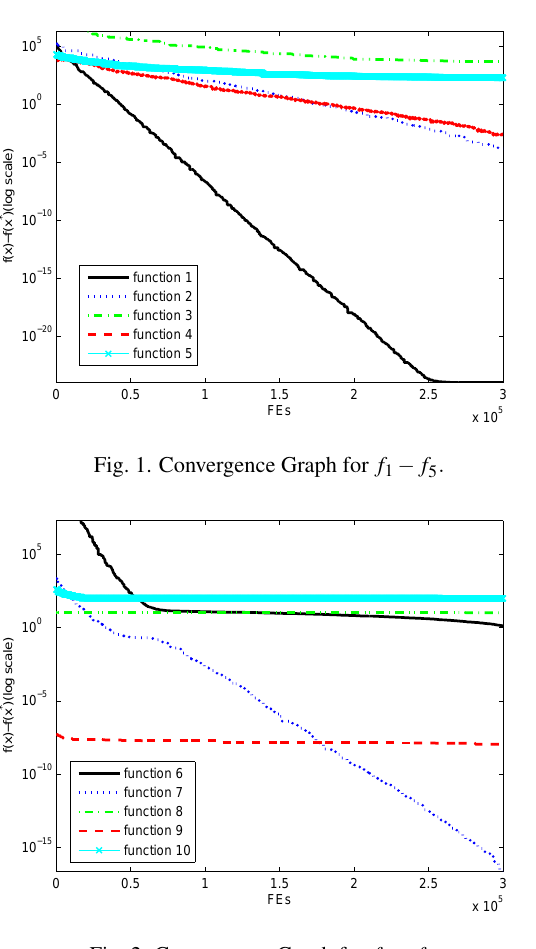
Fig. 2. Convergence Graph for f 6 − f 10 .